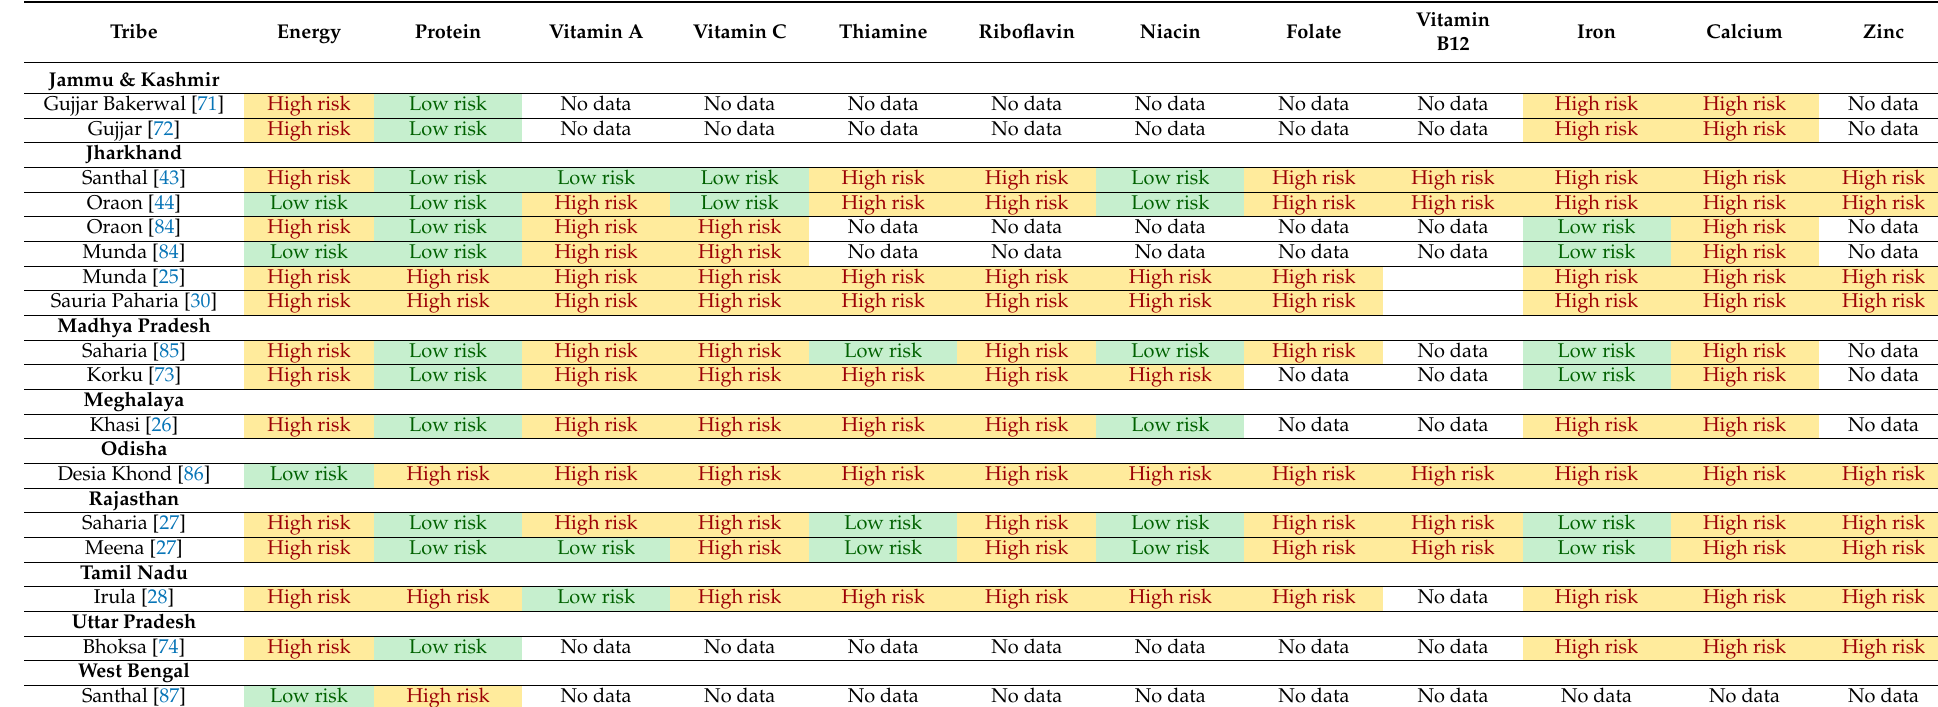
Table 2. Risk of nutritional inadequacy among indigenous women of